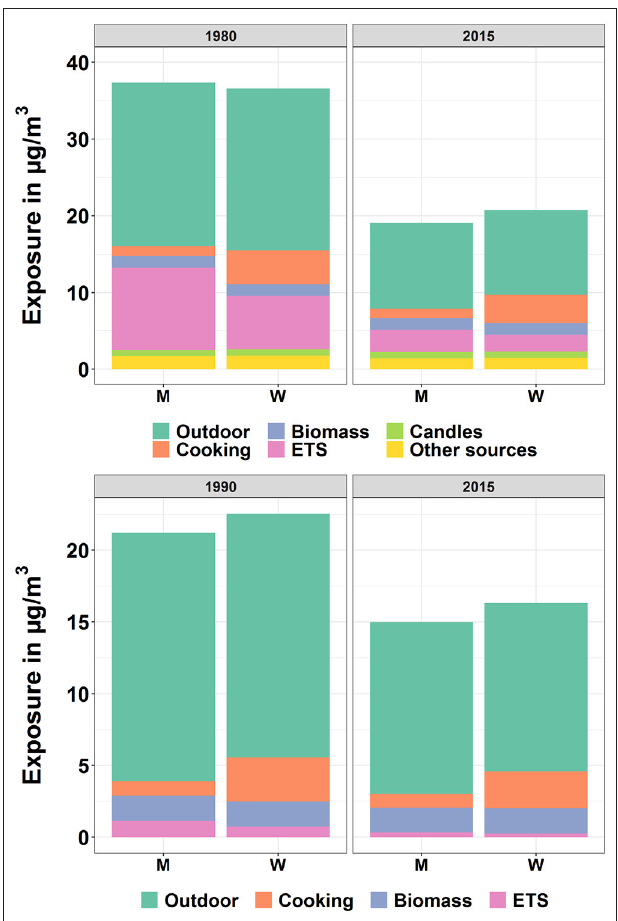
FIGURE 7 | Population-weighted arithmetic mean PM2.5 (upper) and NO 2 (lower) exposure by source and gender for European countries in 1980/1990 and 2015. “M” and “W” represent “Men” and “Women”,